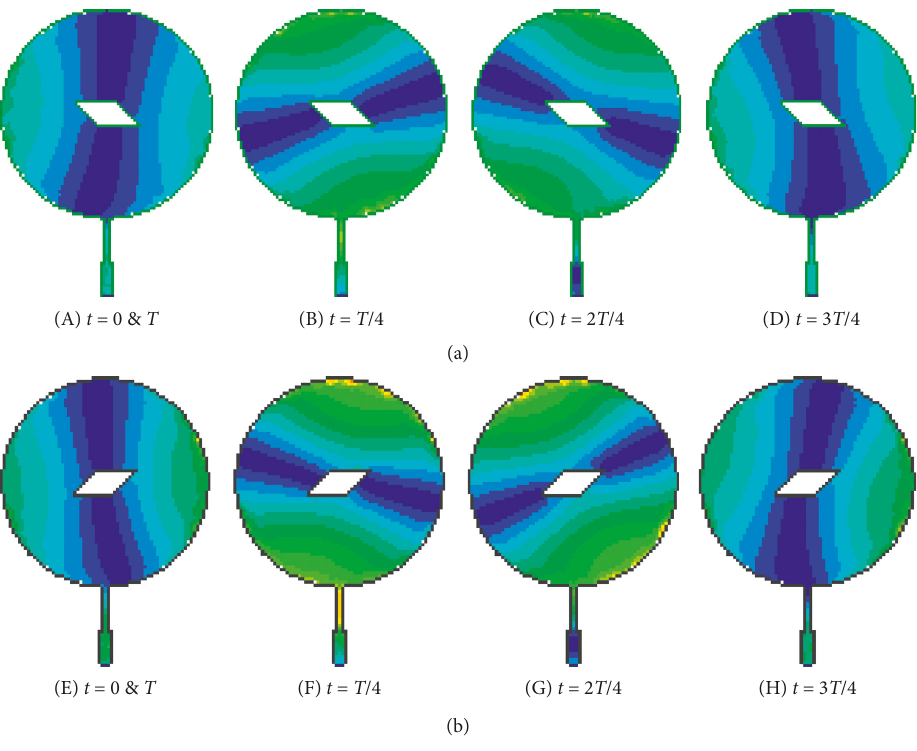
Figure 2: Simulated surface current distribution. (a) LHCP. (b)